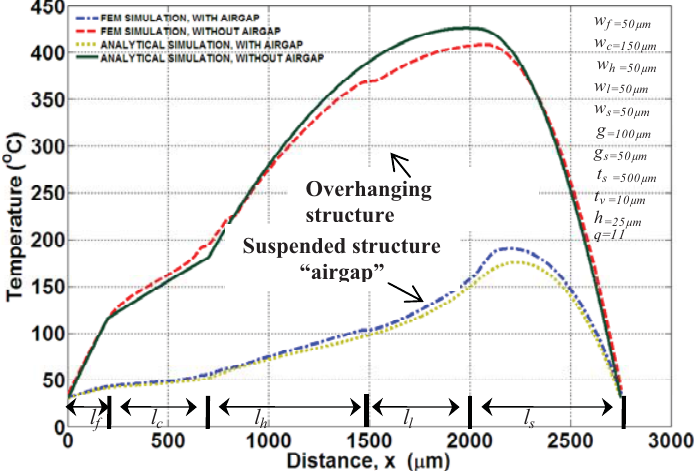
Figure 6. Simulations of combined bent and folded beam